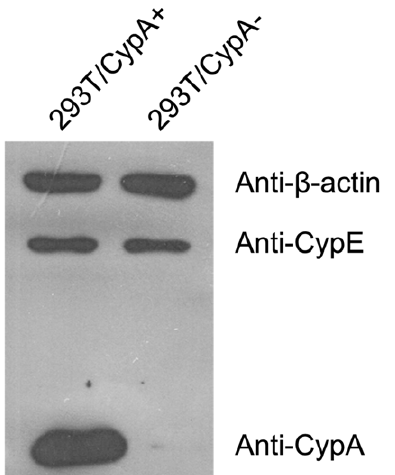
Figure 1. Characterization of the 293T/CypA 2 cell lines. Western blot of total cell lysates from the 293T/CypA + and 293T/ CypA 2 cell lines. The samples were analyzed by immunoblotting with polyclonal anti-CypA and anti-CypE antibodies. b -actin was used as a control.